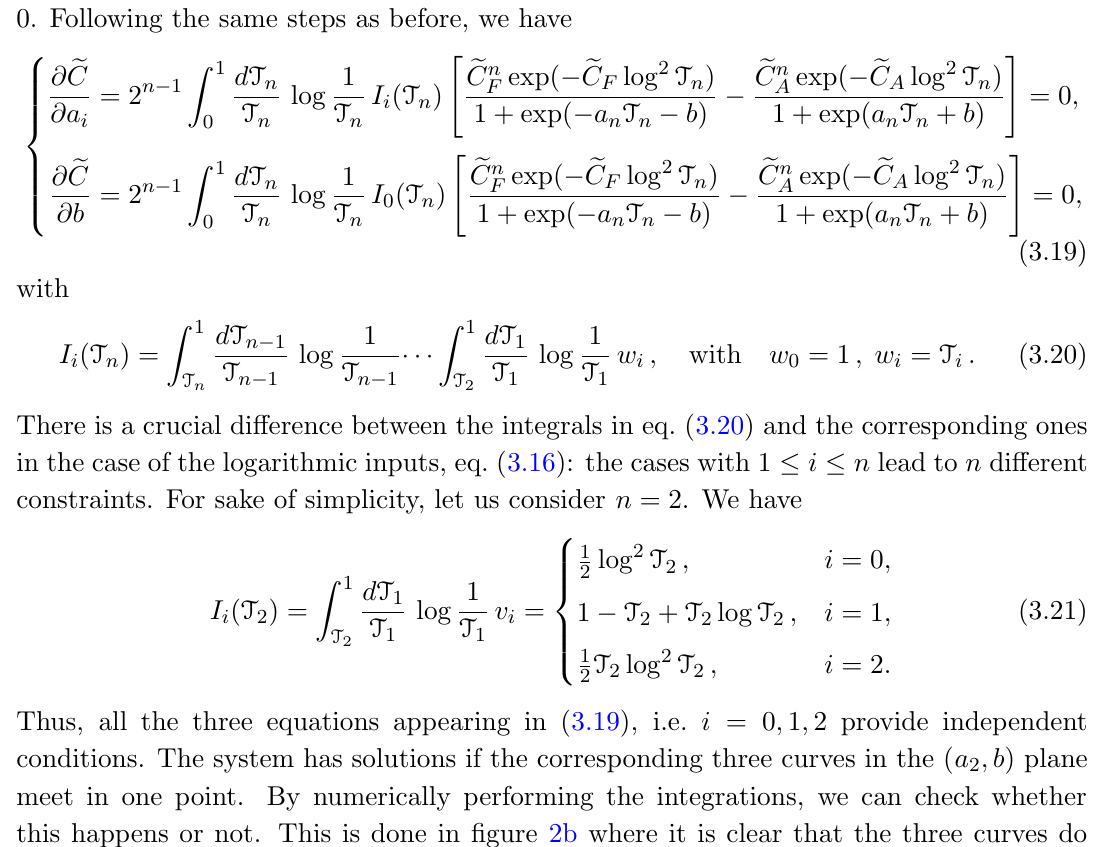
Figure 2 . Solutions of eq. (3.12), in the case n = 2 and with a ( a 2 ; b=a 2 ) plane, for log (left) and linear (right) inputs. Linear